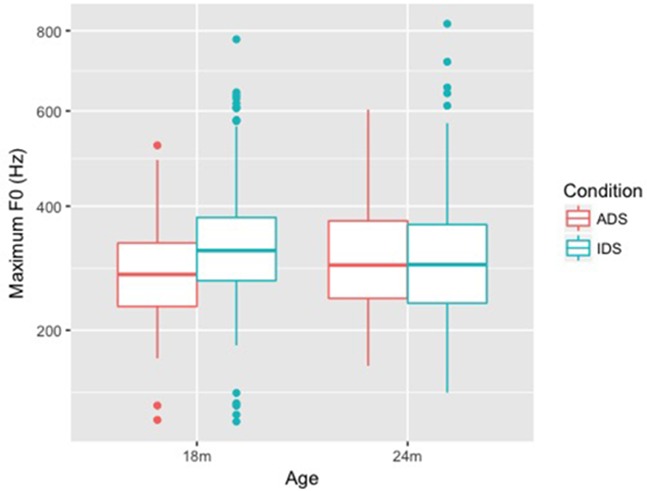
Box plots of Maximum F0 (Hz) for ADS and IDS addressing 18- and 24-month-old children5
.